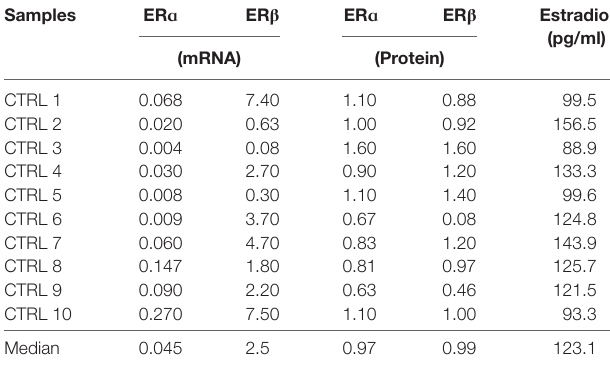
TaBle 6 | Measurements of ER subtype mRNA and protein in freshly isolated systemic lupus erythematosus T cells.